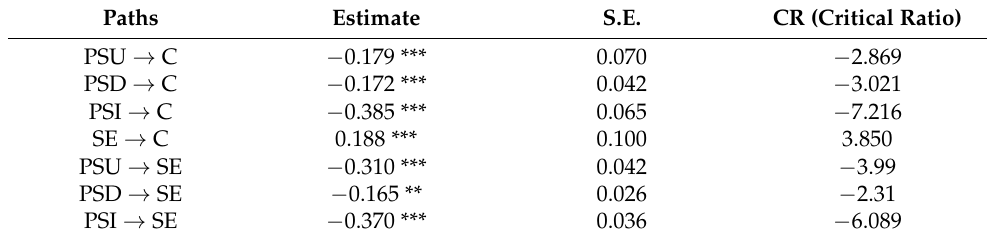
Table 6. Test of direct effects among variables in the mediation effect model. Paths Estimate